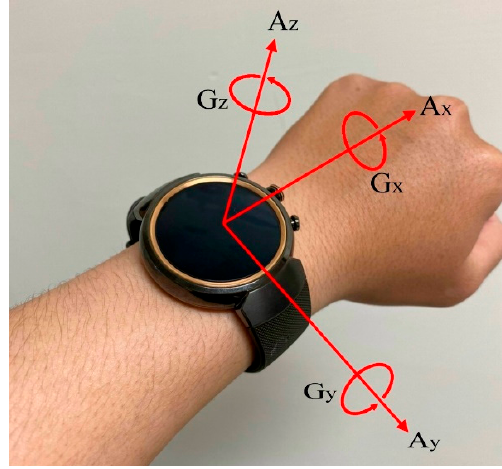
Figure 1. Six-axis recordings of the gyroscope and accelerometer.